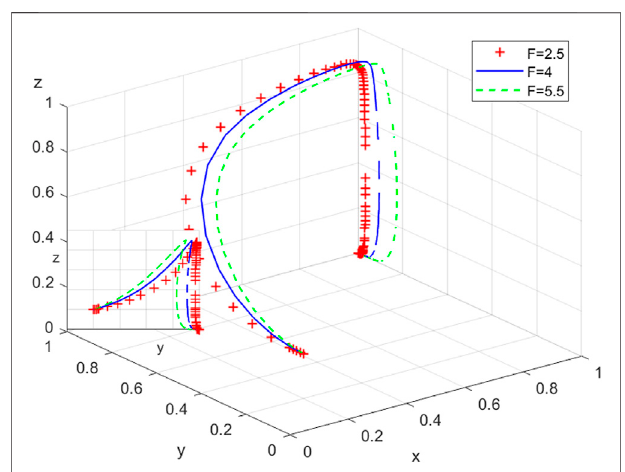
FIGURE 7 | Impact of the punishment of the LGs on MEs on the evolution track of the tripartite evolutionary game.